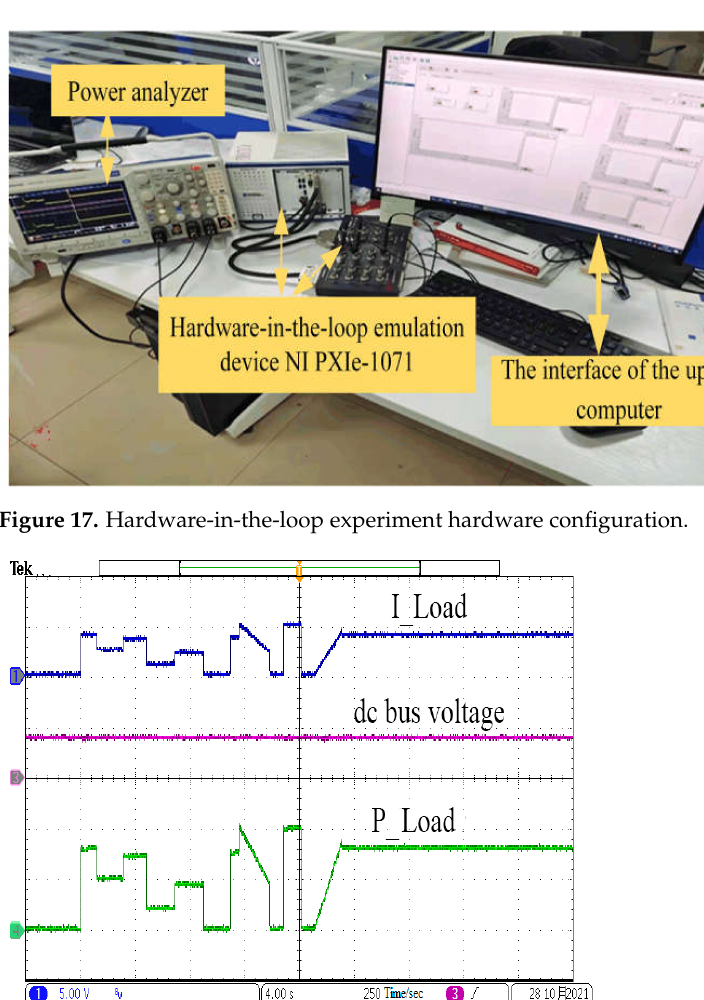
Figure 23. The first PV array’s current, voltage, and power under load constant and radiation changes. Figure 17. Hardware-in-the-loop experiment hardware configuration.